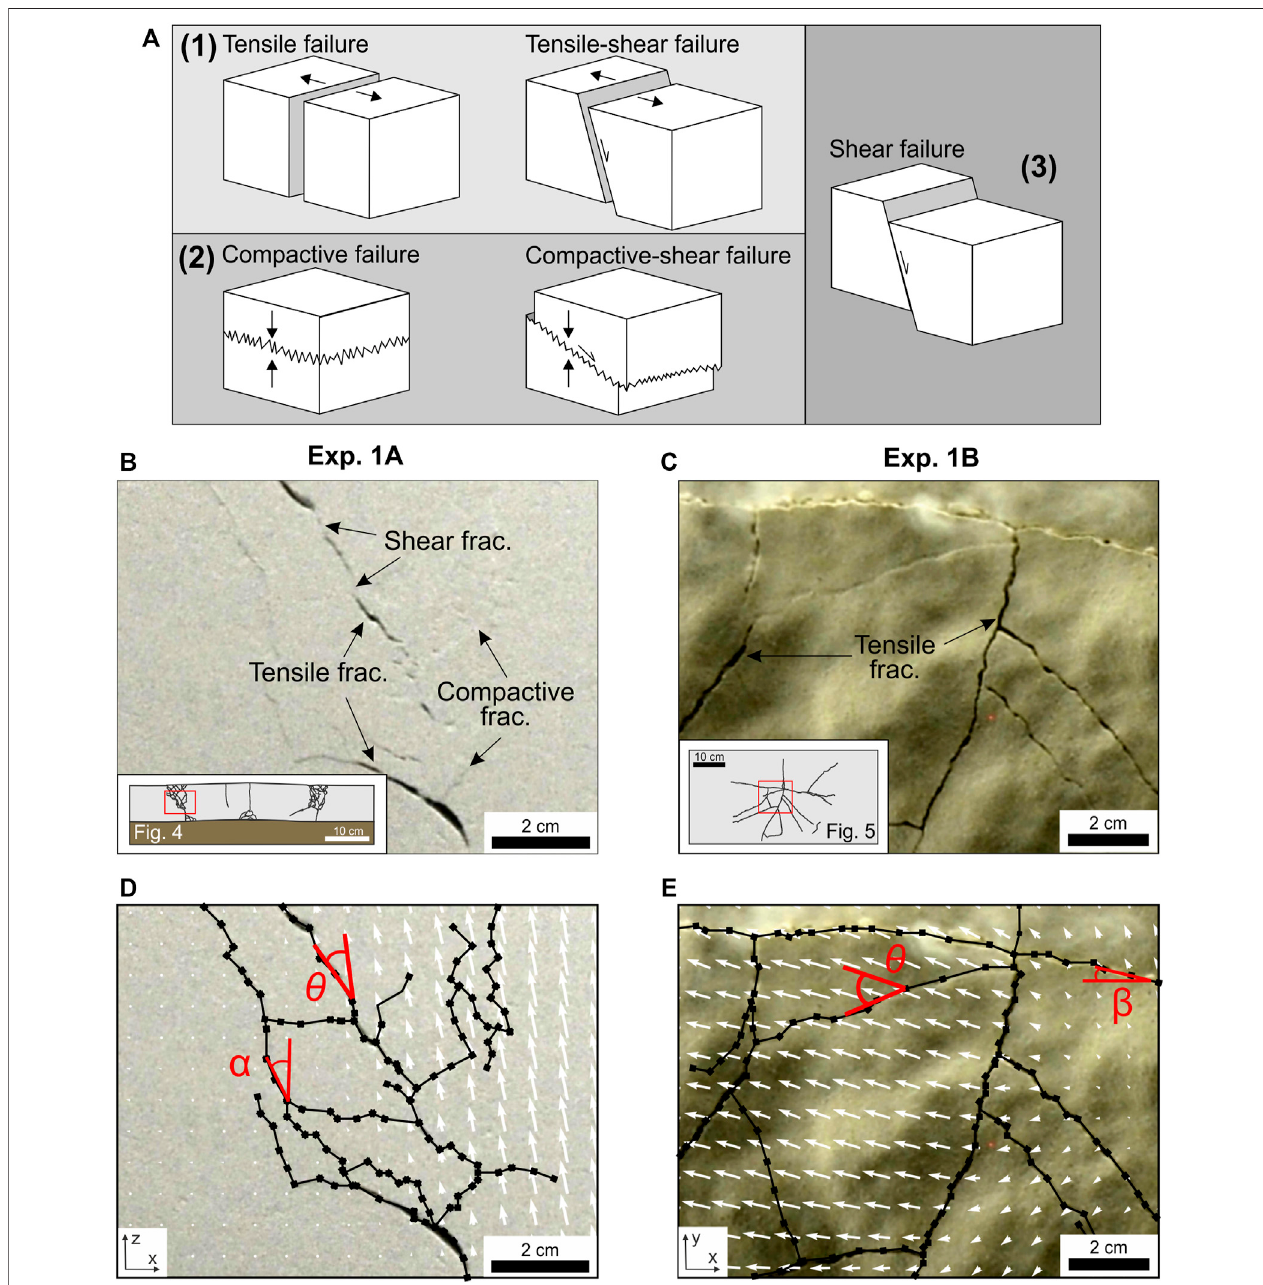
FIGURE 3 | (A) Sketches of the failure modes of fractures (modi fi ed from Ferrill et al., 2020). (B) Side view photo of experiment 1A showing the fracture patterns in the cohesive cover layer (cf. Figure4A ). (C) Top view photo of the 3D experiment 1B displaying fractures on the surface of the cohesive cover layer (cf. Figure 5A ). Tensile fractures are identi fi able by open gaps, compaction fractures by white and grey shadows and shear fractures by lineaments connecting tensile or compactive fractures. Note that in the 3D experiment no compaction fractures are visible at the surface. (D,E) Interpretation of the fractures and division into individual fracture segments (black lines with nodes). The white arrows show the displacement vectors derived from the DIC analysis. α describes the dip and β the strike angle, respectively, of the fracture segment. Θ is used to determine the fracture mode and is de fi ned by the angle between the fracture ’ s dip or strike and the nearest displacement